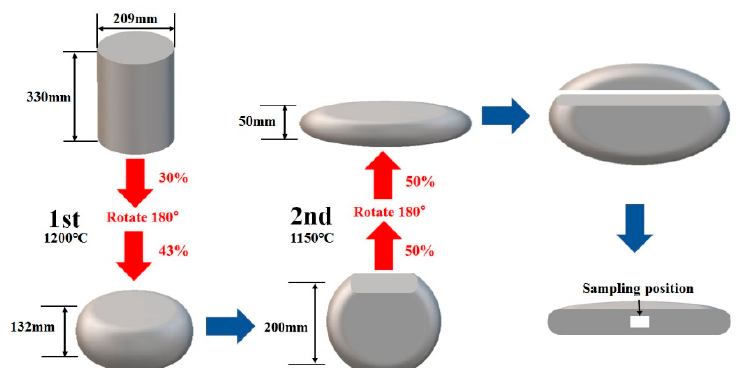
Figure 1. Schematic diagram of the two-step multi-directional isothermal forging and sampling position in the forged plate.